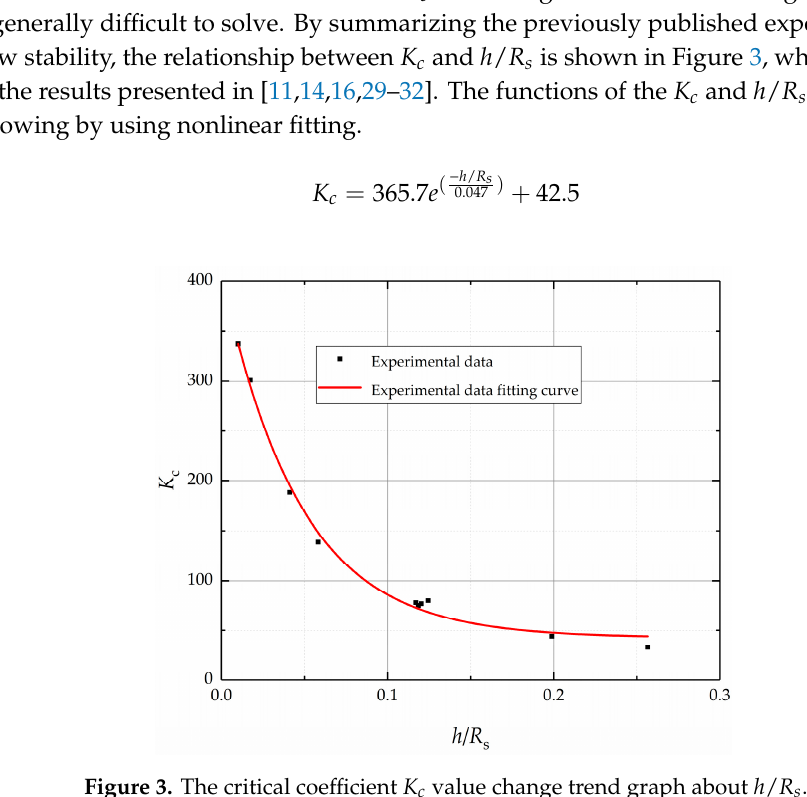
K value change trend graph about c